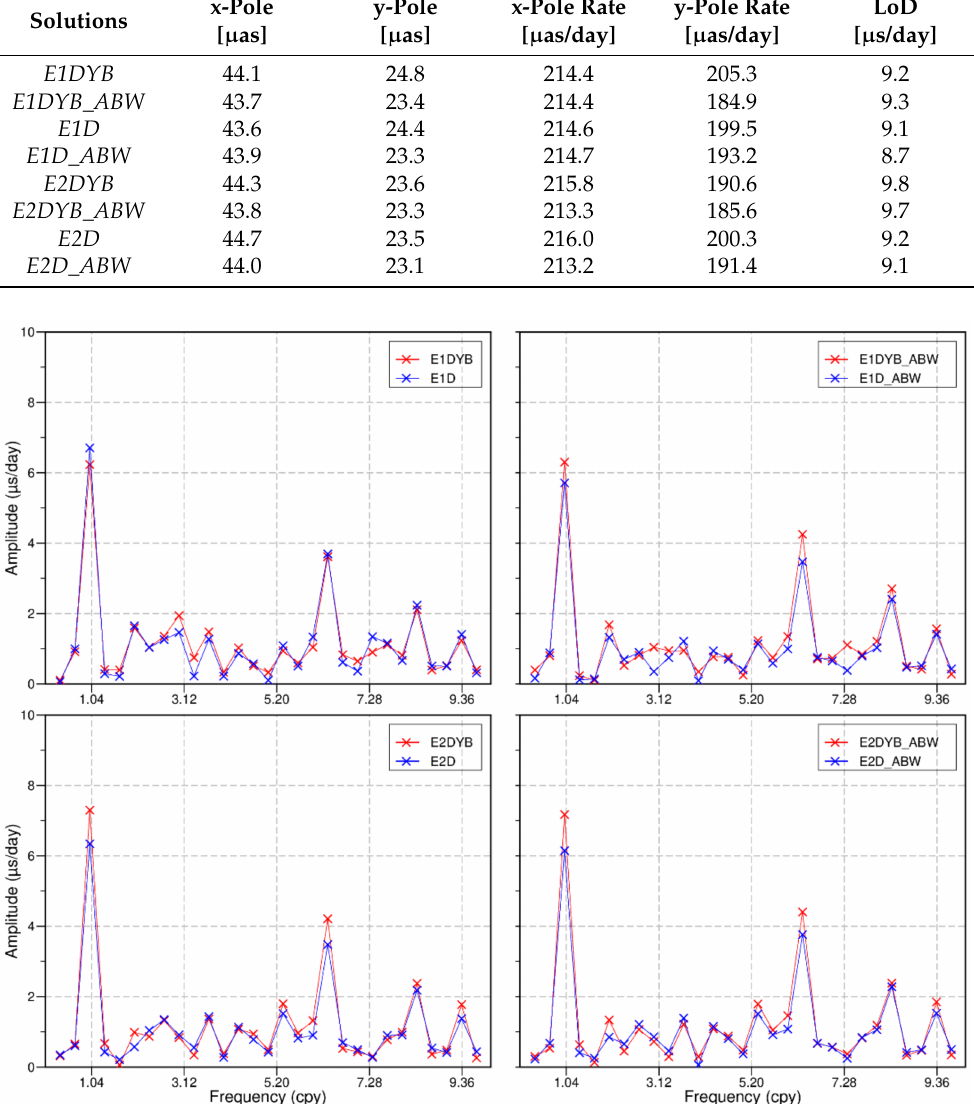
Figure 12. Power spectra of the LoD differences with respect to the IERS EOP 14C04 product. Upper panels: ECOM1 for the empirical SRP modeling, lower panels: ECOM2 for the empirical SRP modeling; left panels: no a priori SRP modeling, right panels: adjustable box-wing for the a priori SRP